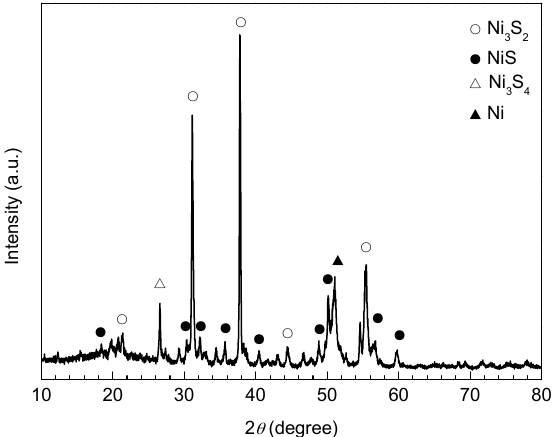
Figure 8. XRD spectra of the corrosion scale on the Ni-based alloy coating exposed to the H 2 S/CO 2 environment for 360 h at 140 °C.